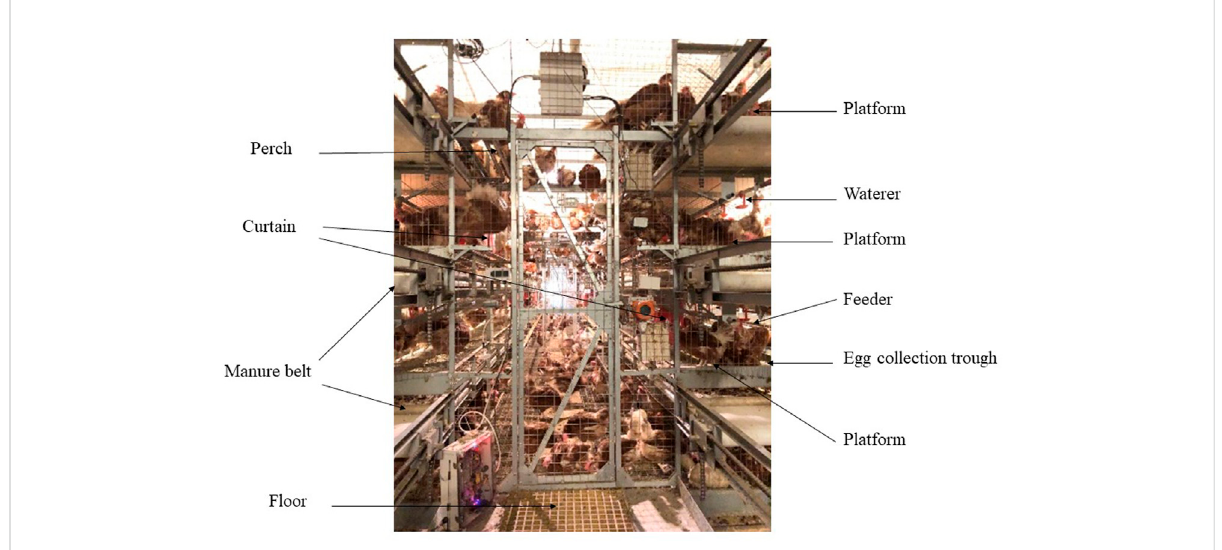
FIGURE 1 Image of aviary system employed in this study. The dimension (length × width × height) of the unit was 480 cm × 280 cm × 330 cm. Image depictsthemainequipmentinsidethesystem( fl oorarea134,400 cm 2 ,totalsystemarea396,144 cm 2 ),includingfeeders,waterers,perches,manure belts, litter area, nesting area and suspended platforms (261,744 cm 2